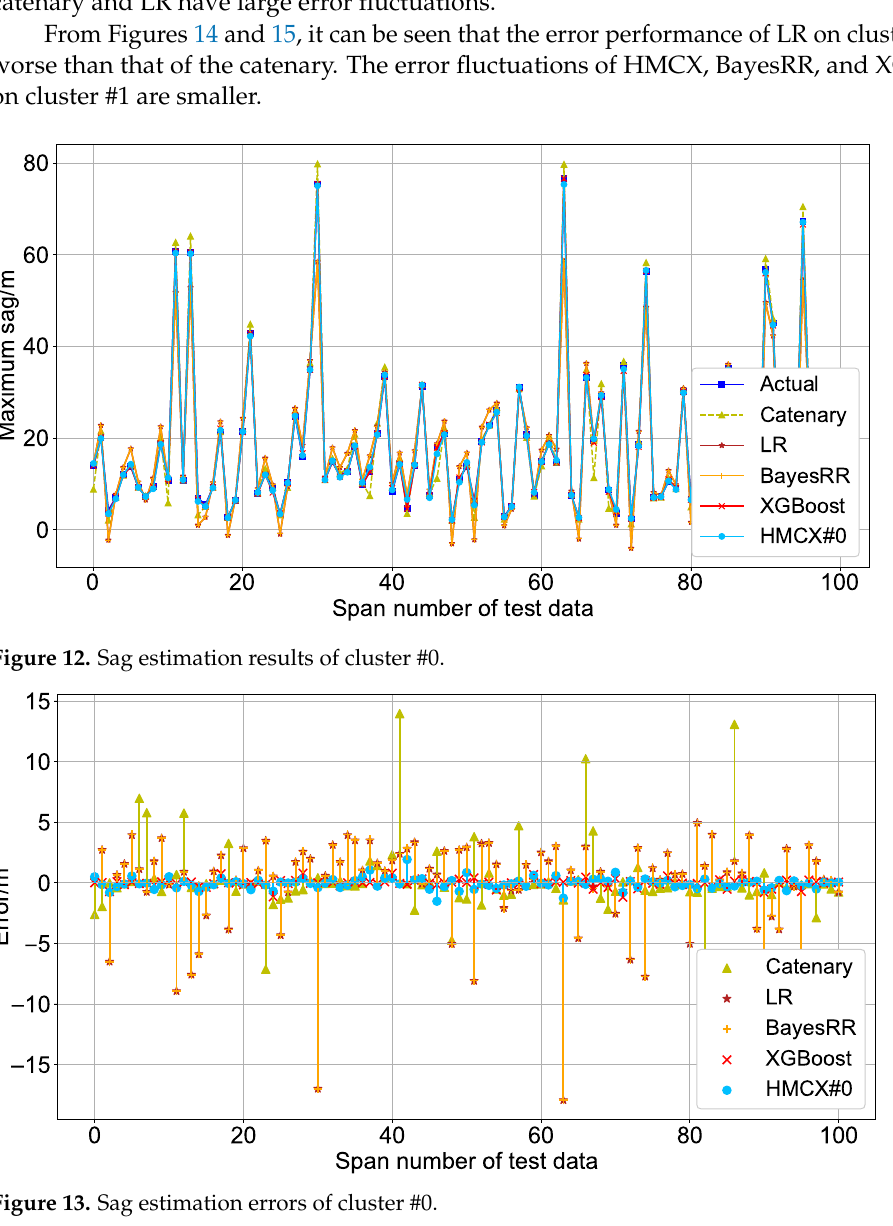
Figure 13. Sag estimation errors of cluster